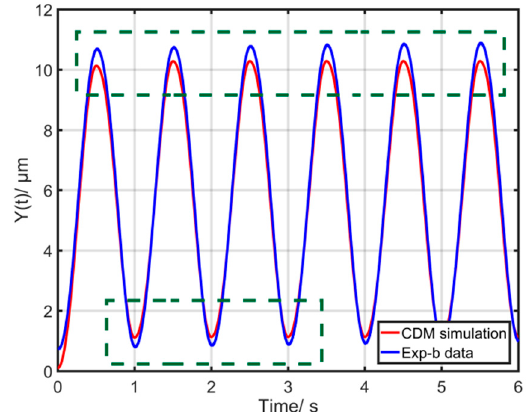
Figure 2. Comparison of the output displacements between experimental data (Exp-b) and simulation of CDM.